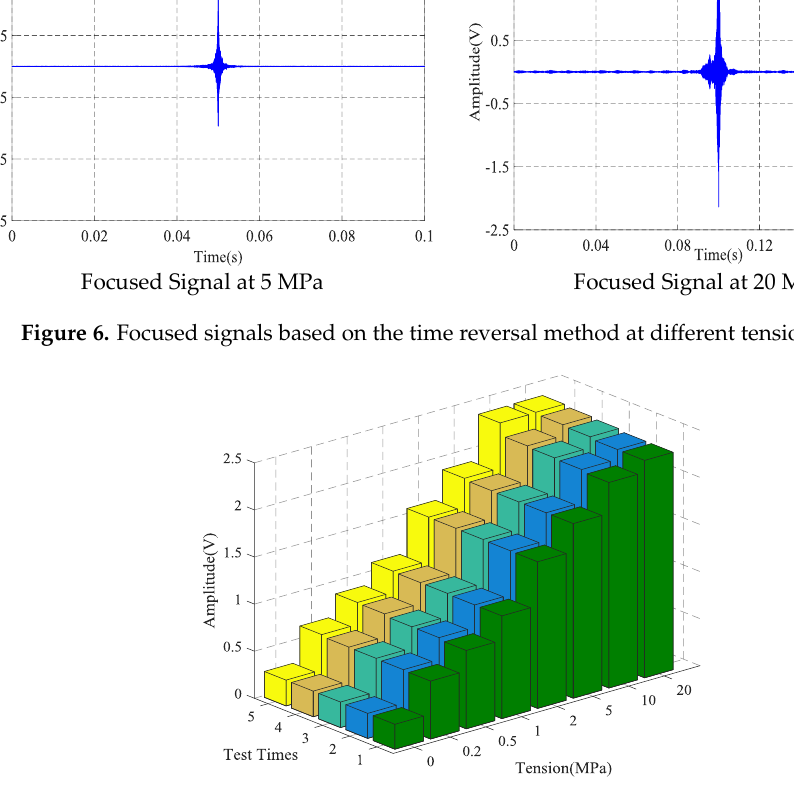
Figure 7. The magnitude of the focused signals based on time reversal for five repeated tests.